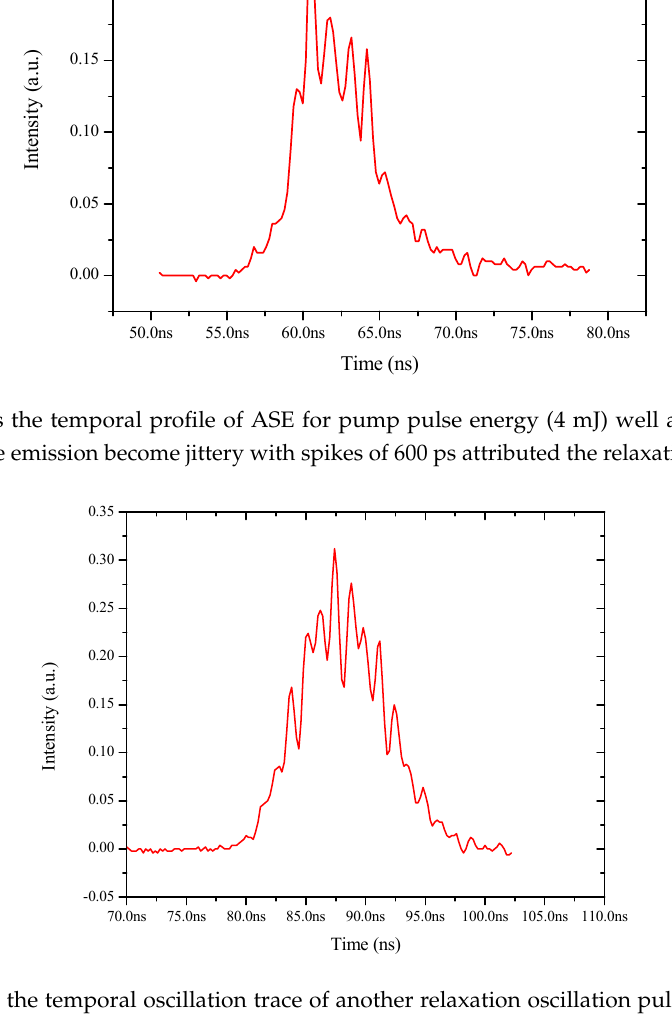
Figure 7. Shows the temporal oscillation trace of another relaxation oscillation pulse, indication of non-reproducible spikes.